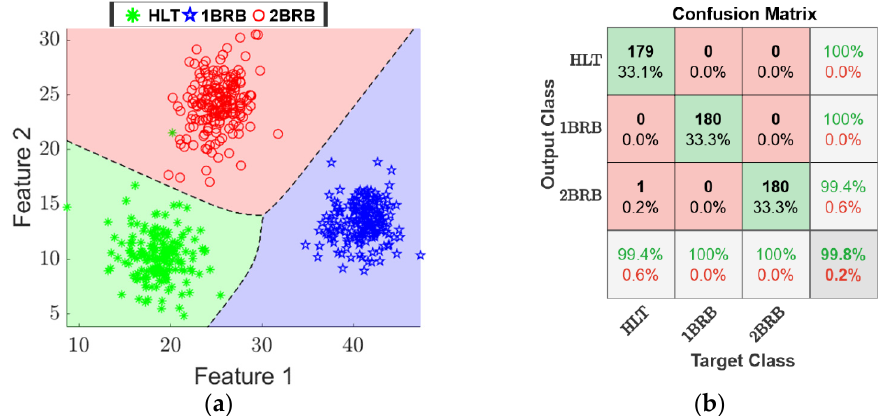
Figure 13. Classification results of the proposed methodology obtained for the ABB soft-starter. ( a ) Resulting decision regions modelled by the proposed NN-based classifier over the 2-dimensional space; ( b ) Confusion matrix.